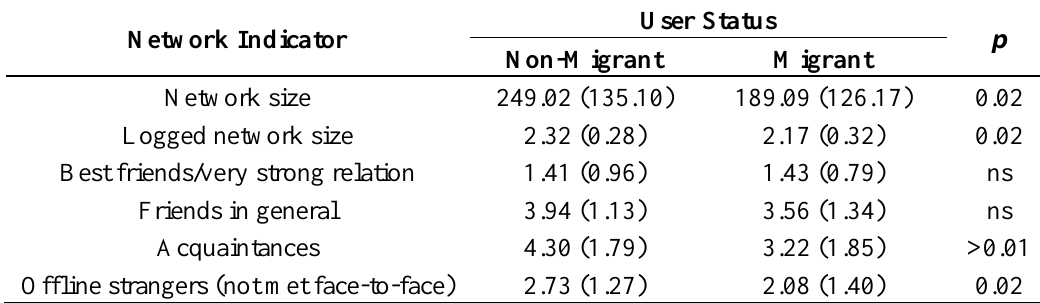
Table 2. Mean scores and standard deviations (in parentheses) for non-migrant and migrant